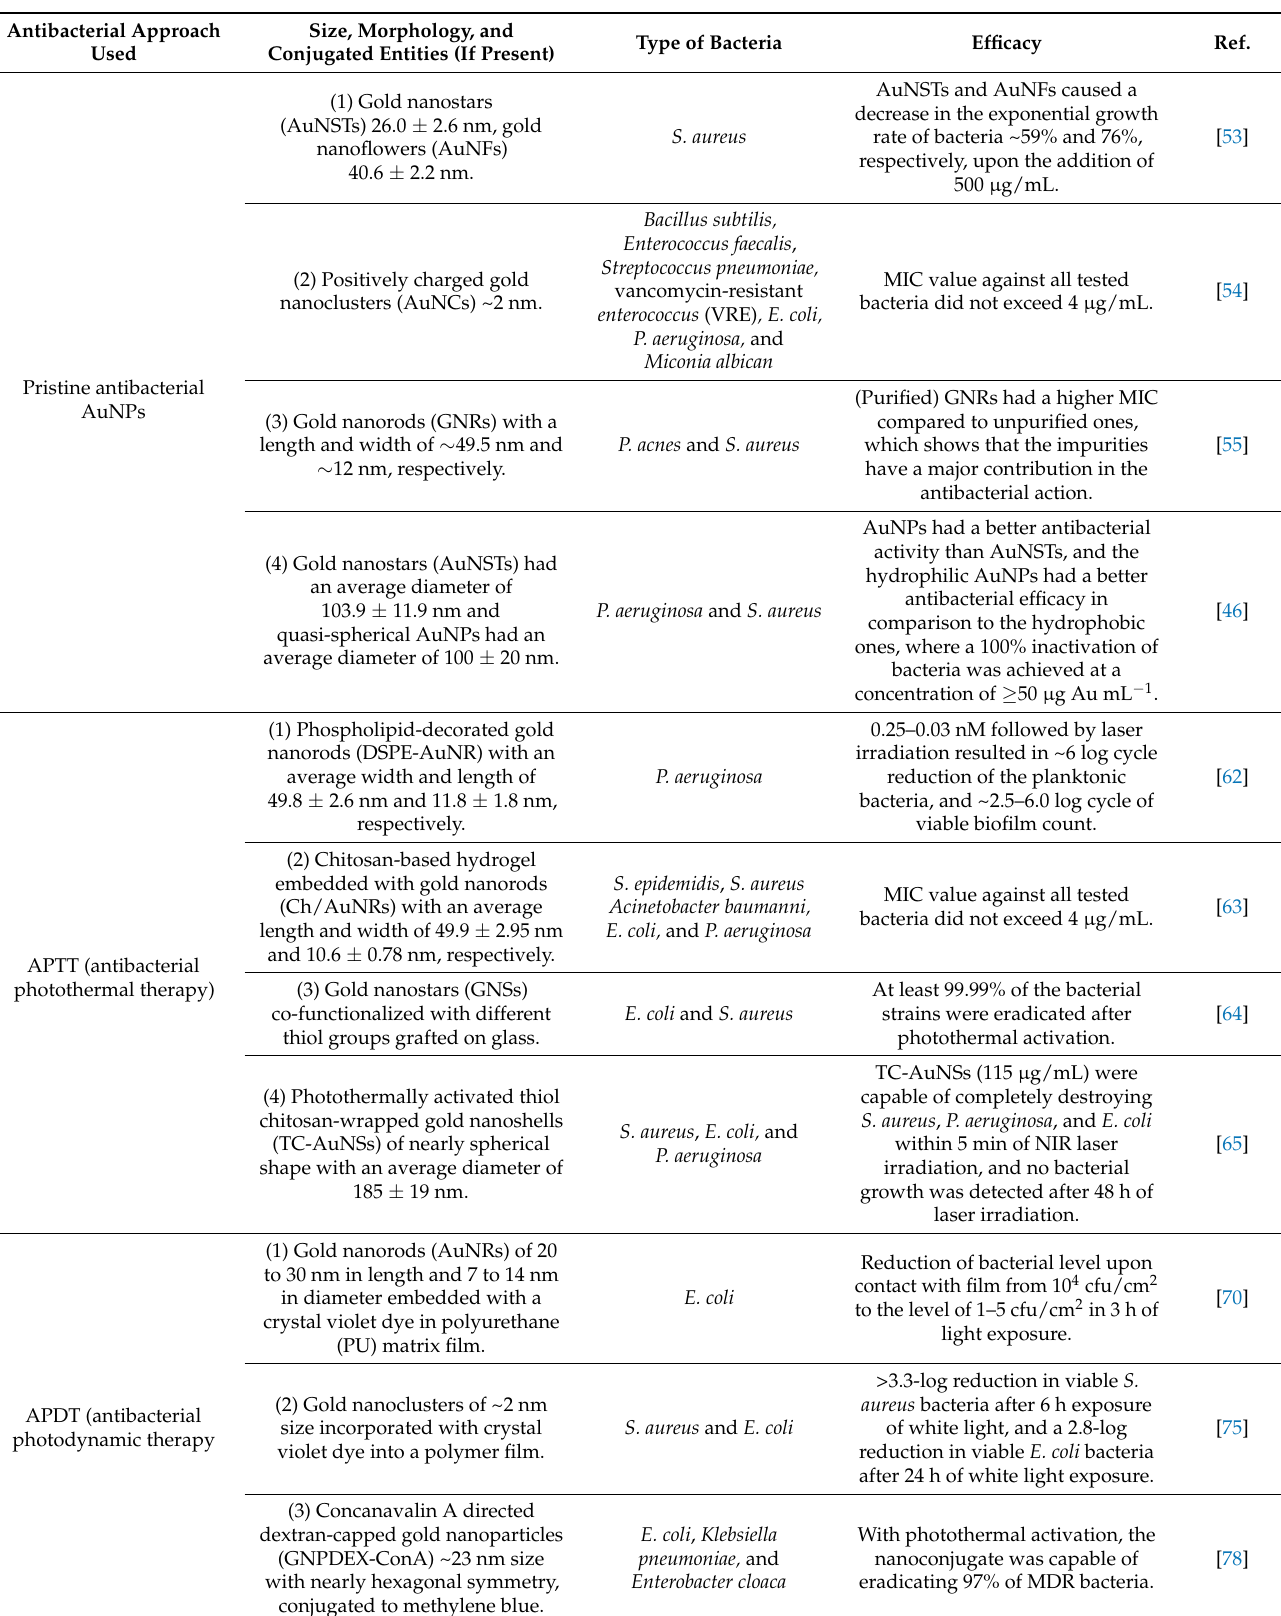
Table 2. Summary of all the antibacterial AuNPs approaches discussed in previous section. Size, Morphology, and Type of Bacteria Conjugated Entities (If Present)